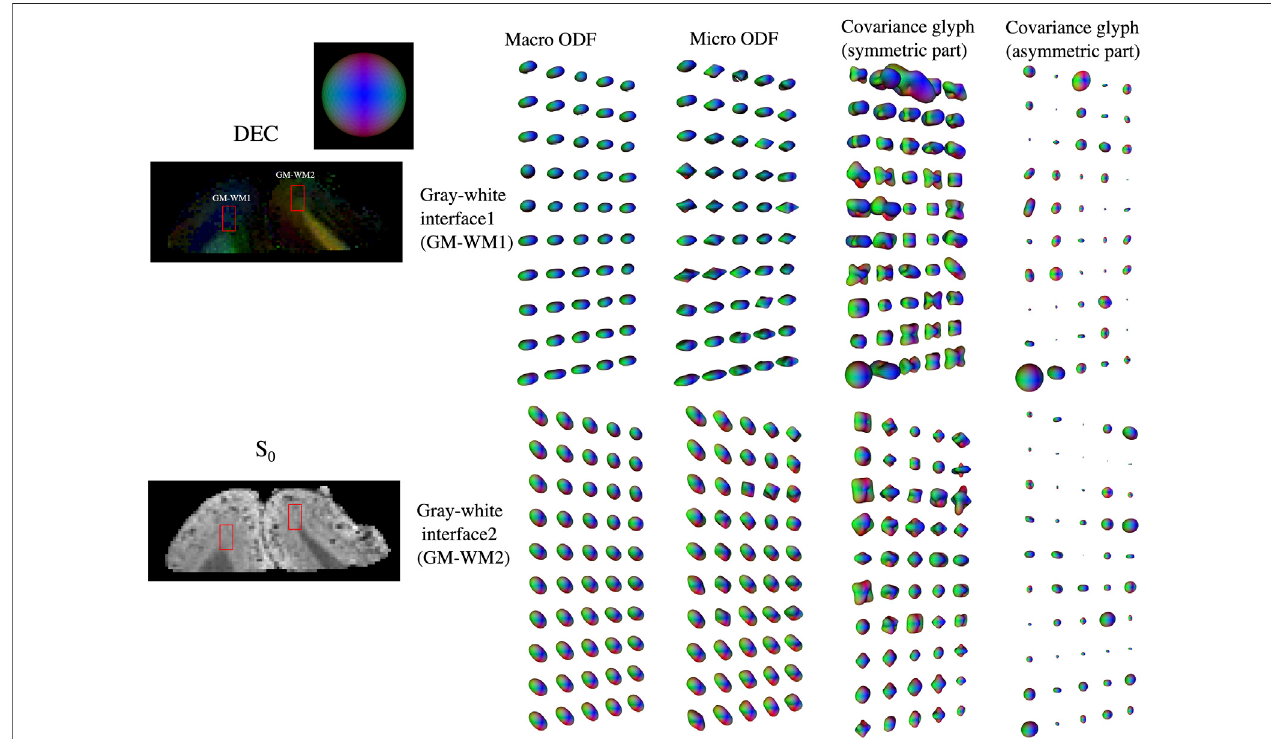
FIGURE 3 | Orientation dispersion observed in macaque visual cortex shown by comparing the macro and micro ODFs. The need for a DTD model and additional information obtained beyond the kurtosis tensor model is demonstrated by plotting the symmetric and asymmetric parts of the covariance tensor of the constrained normaltensorvariatedistribution.Tworegionsofinterest(ROIs)atgray-whitematterinterfaceregionsarehighlightedinthedirection-encodedcolor(DEC)map,showing the principal direction of the mean diffusion tensor, and S 0 map.